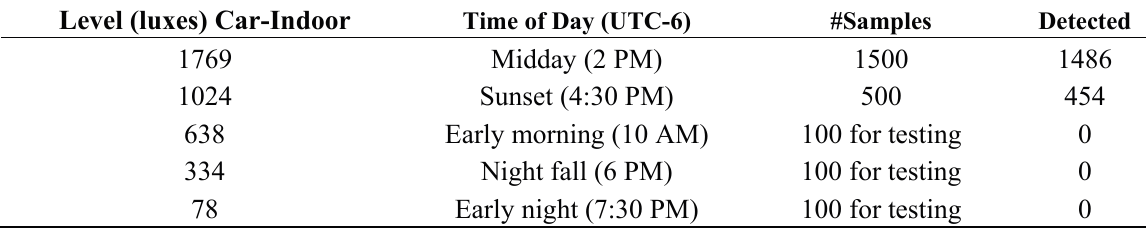
Table 6. Lighting levels for video and number of samples taken.